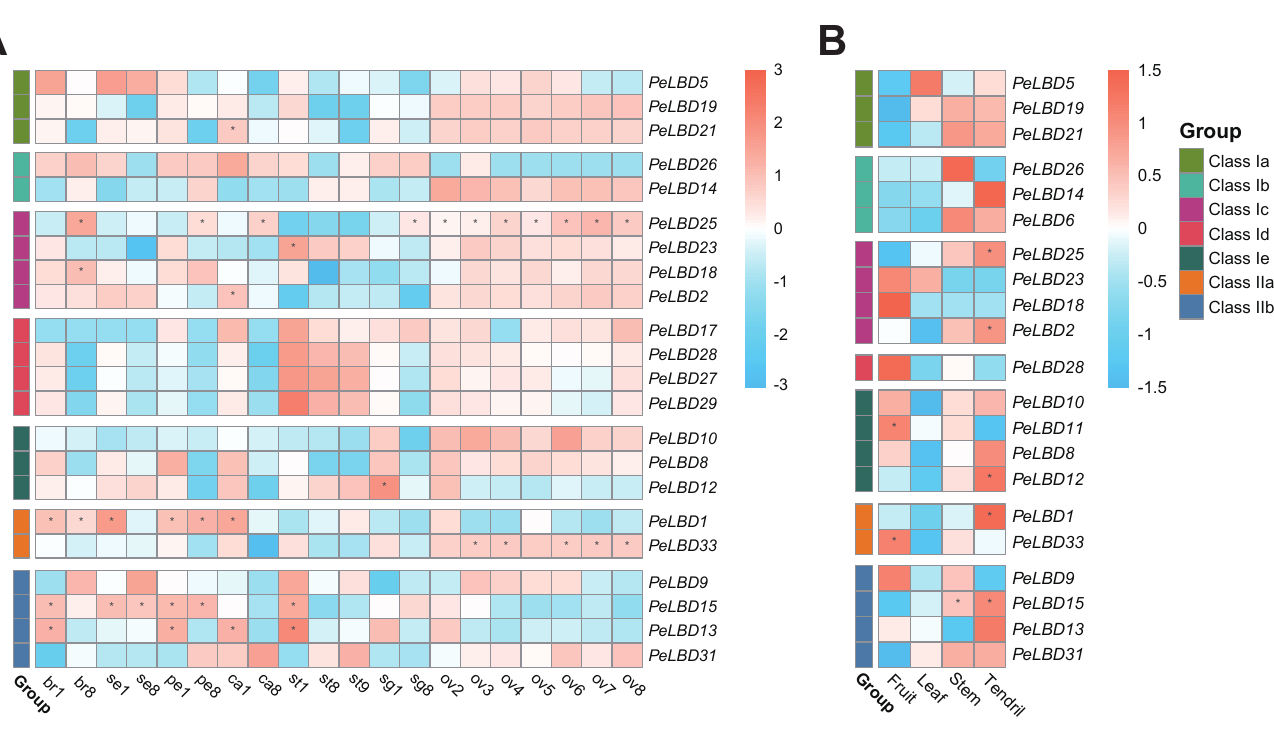
Figure 8. The expressional pattern of LBD genes in passion fruit. Heatmap of expression levels of 33 PeLBD genes in ( A ) floral tissues at different developmental stages. br, bract; se, sepal; pe, petal; ca, corona filament; st, stamen; sg, stigma; ov, ovule; numbers represent developmental stages, 1 and 2 was early stage, 8 was late stage (Table S9); ( B ) Other tissues including fruit, leaves, stems, and tendrils. The heatmap was created based on the log 2 (TPM + 0.01) value of PeLBDs and normalized by row. The TPM value higher than 32 was shown as abundant genes, and marked with “*”. Differences in gene expression changes are shown in color as the scale, coral for high expression and blue for low